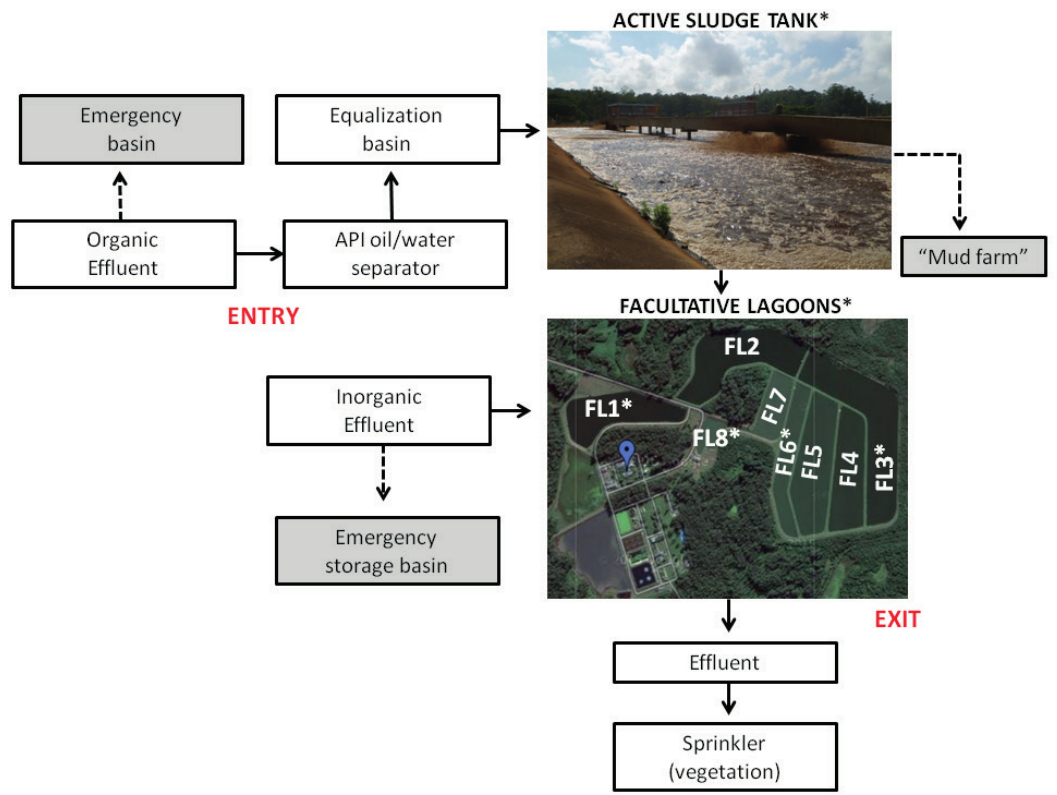
Figure 1 - Wastewater treatment plant pathway. (  ) effluent pathway. The gray boxes represent emergency tanks for effluent and activated sludge overloads. *Collection